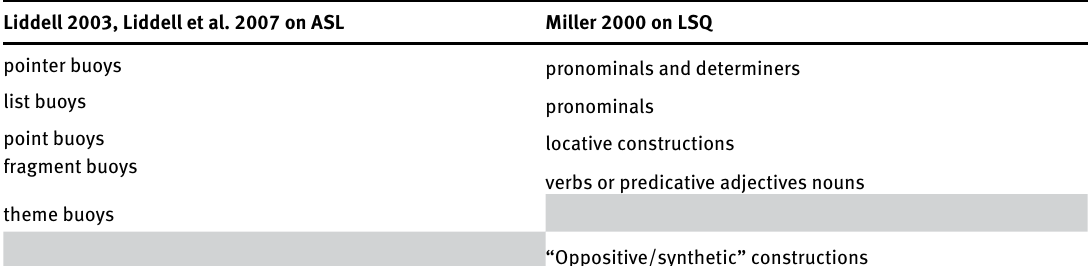
Table 1 . Comparison of two attempts at categorizing weak hand holds, one focusing on form, the other on function. Liddell 2003, Liddell et al. 2007 on